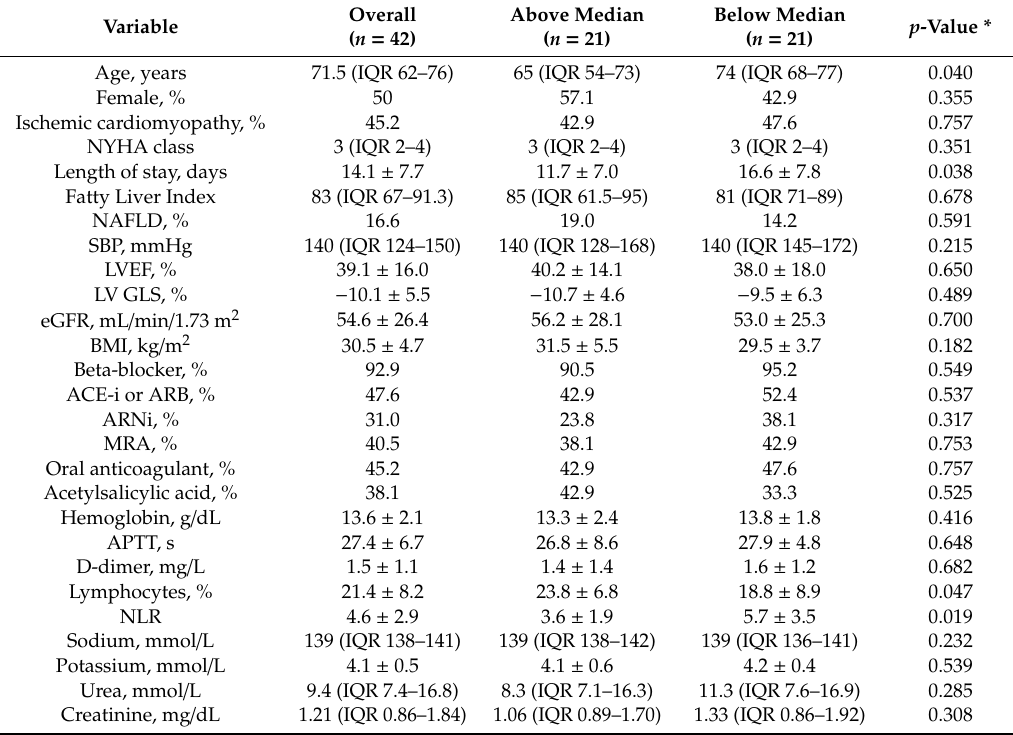
Table 1. Baseline characteristics of enrolled patient cohort according to the median of measured right ventricular free wall longitudinal strain (RV